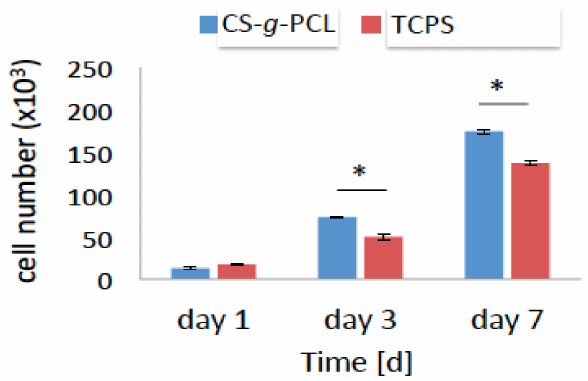
Figure 5. Viability and proliferation assay showing the number of the MC3T3-E1 pre-osteoblastic cells cultured on the CS- g -PCL surface and on tissue culture treated polystyrene (TCPS) after 1, 3, 7 days in culture. Optical density values of viability are normalized to the cell number using a calibration curve. The number of cells cultured on the CS- g -PCL surfaces was similar to those on TCPS 1 day after seeding but after 3 and 7 days it was significantly higher for the cells cultured on the CS- g -PCL copolymer